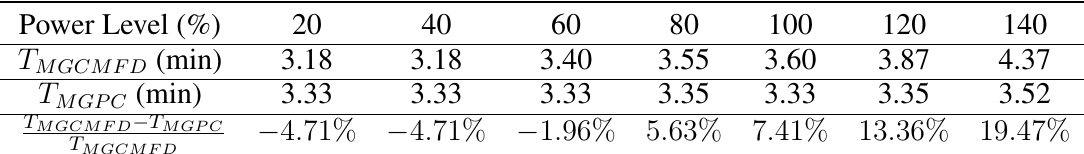
Table 2: Run Time for 3D Problem 1